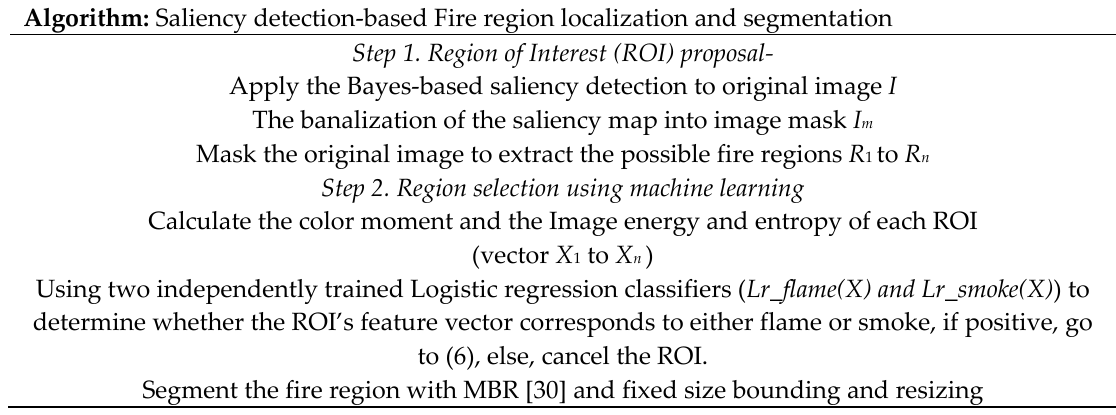
Figure 3. Saliency detection and logistic regression-based segmentation algorithm.